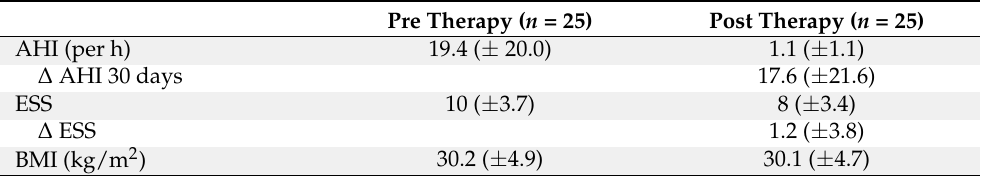
Table 1. Clinical parameters of the 25 patients as median AHI, ESS and BMI. For the post therapy AHI, mean values measured over the last 30 days of therapy were used. Differences in AHI and ESS compared to prior therapy were expressed as ∆ AHI and ∆ ESS. Values are presented as mean ± SD. AHI per hour less than or equal 5.0 is defined as normal. According to WHO standards, overweight is defined as a BMI greater than or equal to 25; ESS less than or equal to 9.0 is defined as